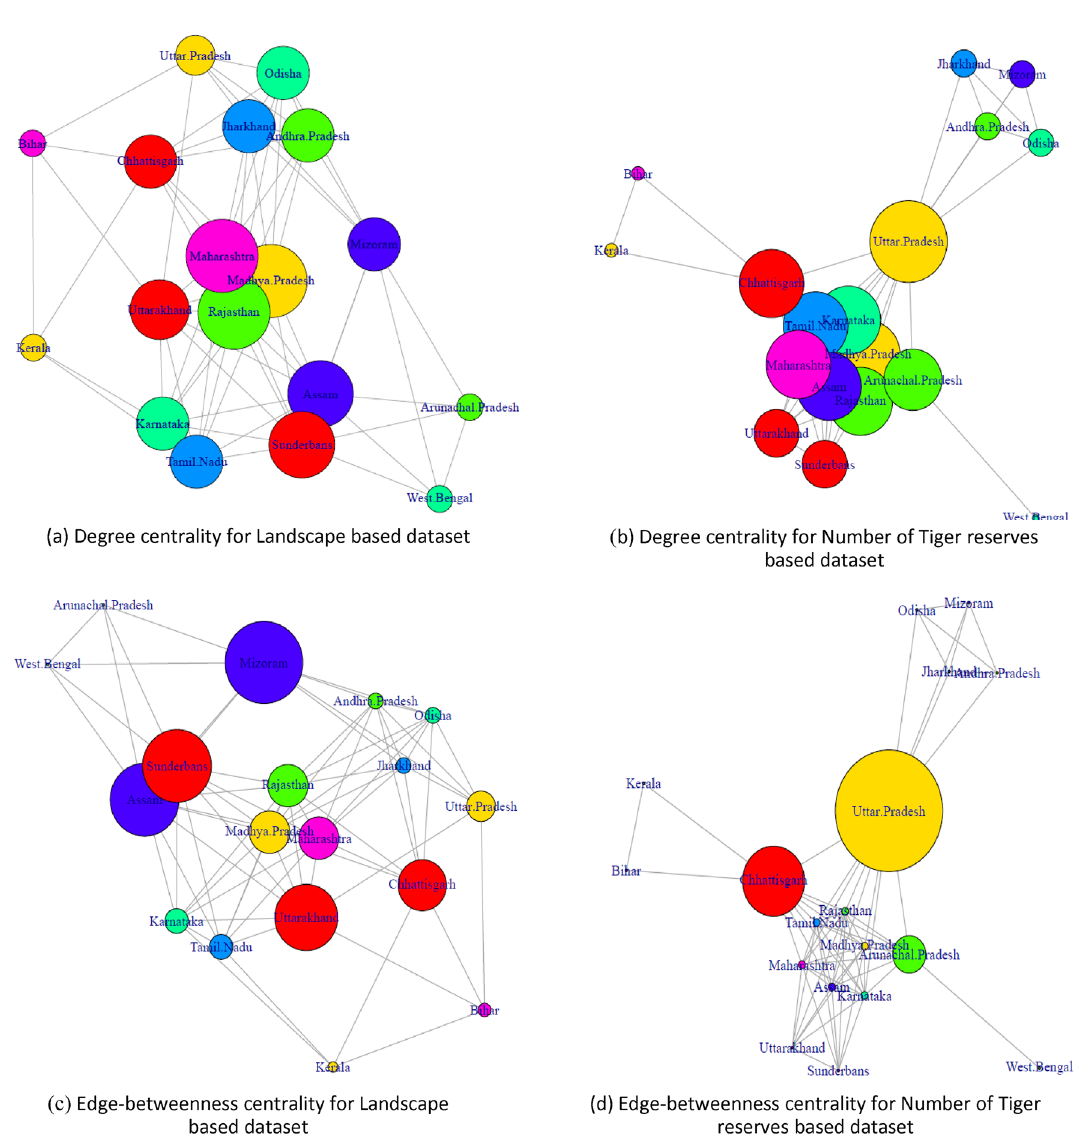
Figure 2. Degree and edge-betweenness centrality for Landscape based dataset and Number of Tiger reserves based